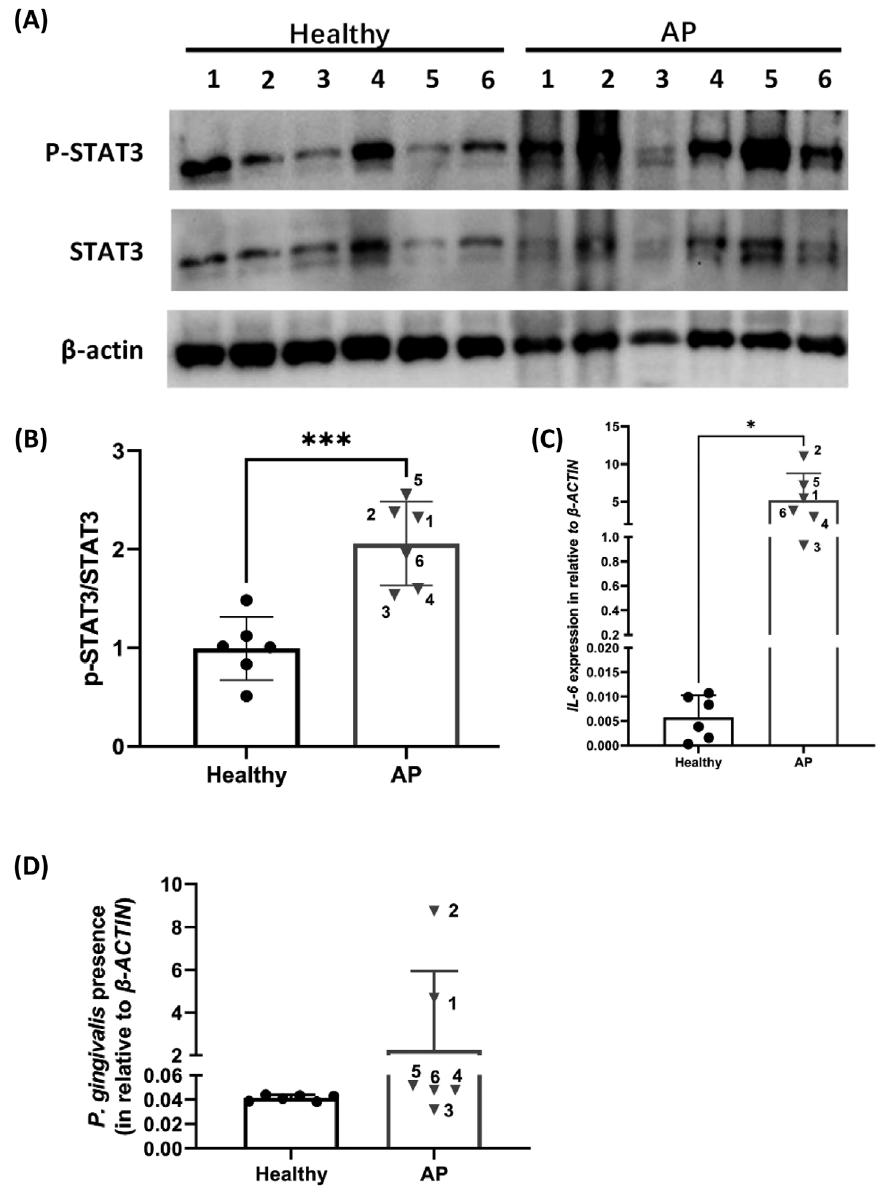
Figure 2- IL-6/STAT3 expression and P. gingivalis presence in human apical periodontitis tissues. (A), representative western blot images for p-STAT3, STAT3, and β-actin. (B), grayscale analysis of p-STAT3 expression (relative to STAT3). (C), gene expression level of IL-6 in healthy pulps and apical tissues. (D), P. gingivalis detection in apical tissues via RT-qPCR using universal P. gingivalis primers, showing that P. gingivalis were present in samples #1 and #2. Healthy, healthy human dental pulps; AP, apical periodontitis lesion tissues. Sample numbers are indicated beside the dots. *p<0.05;